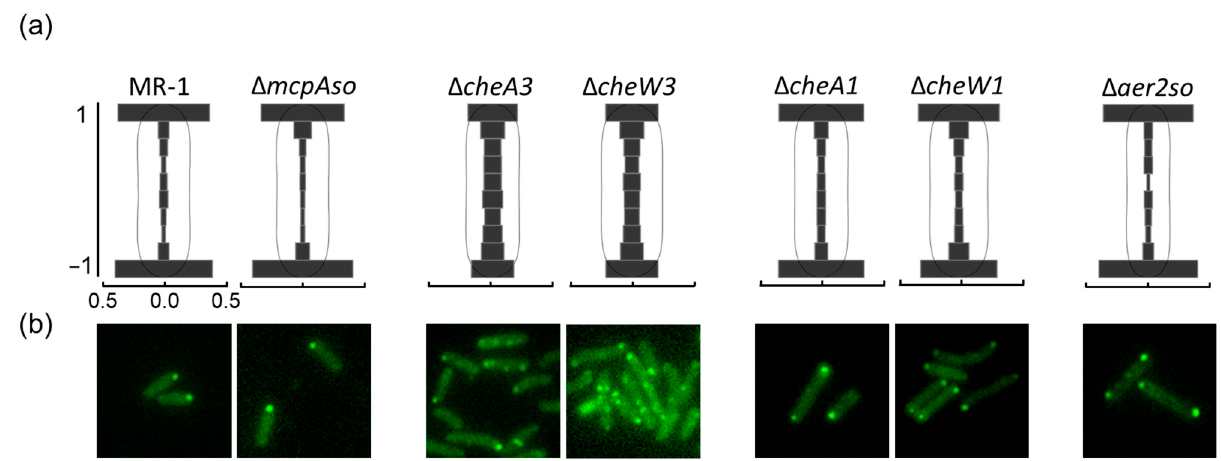
Figure 6. McpAso localization in various S. oneidensis mutants. ( a ) Histograms of the fluorescent cluster distribution across the transversal axis cells in the different mutants are shown. On the x -axis, the frequency of the clusters is represented and, on the y -axis, their relative position in the cell. ( b ) Fluorescence images of the various S. oneidensis mutants in the stationary phase of growth in a minimum medium are represented. The analysis was performed from three independent experiments.